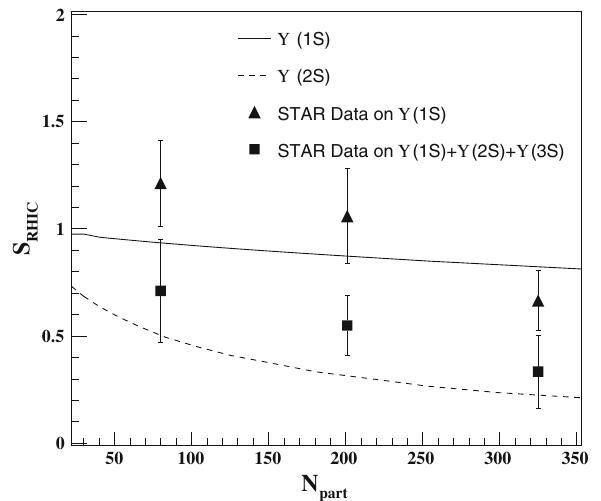
<30 GeV/c, |y|<1.6) T